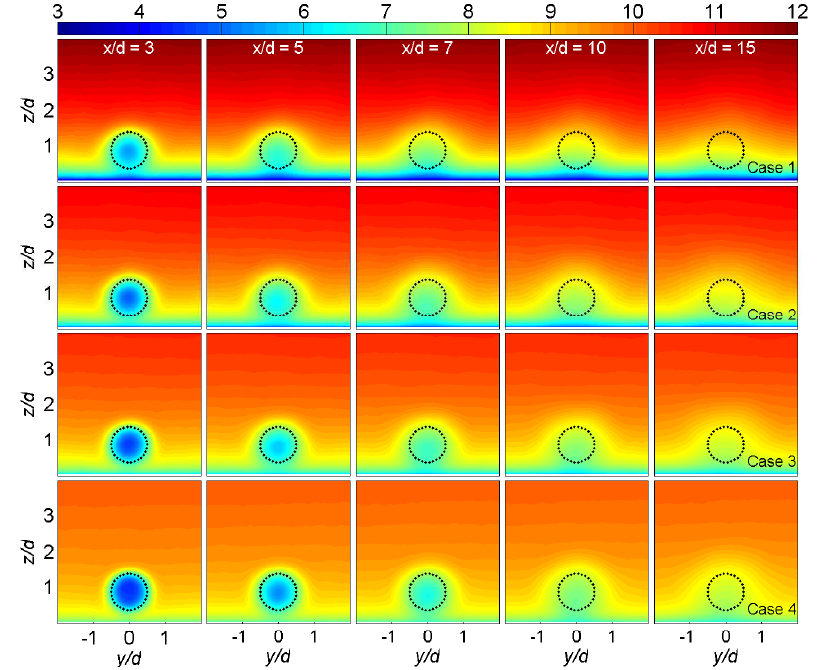
Figure 4. Contours of the time-averaged streamwise velocity u (m s − 1 ) at the lateral cross- sectional planes of x/d = 3, 5, 7, 10, and 15 for the turbines installed over flat surfaces with four different roughness lengths. The dotted line denotes the rotor